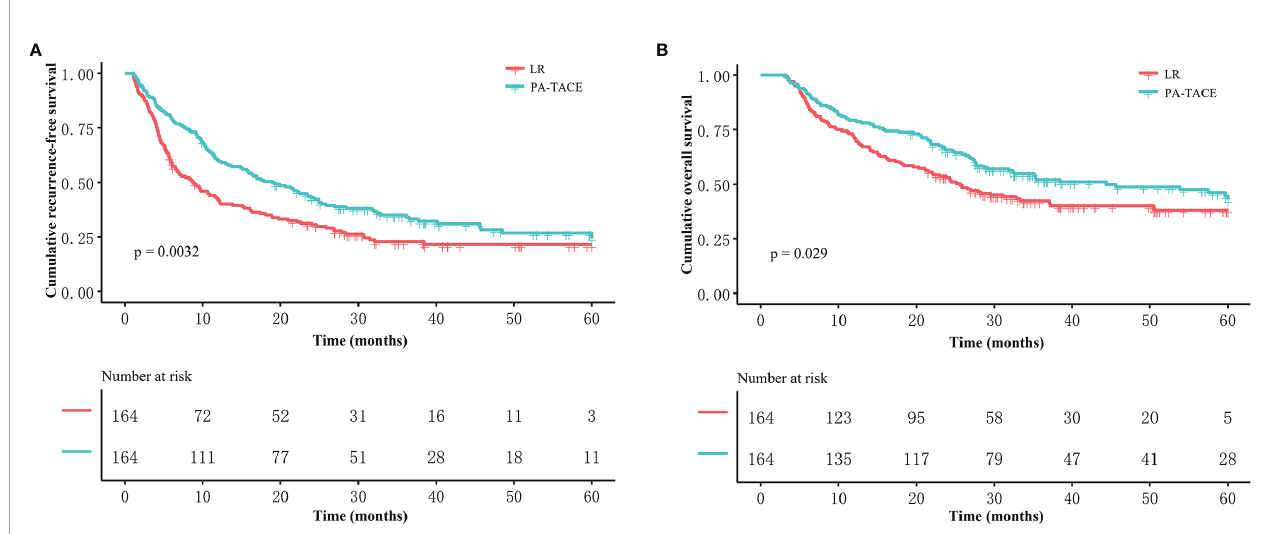
FIGURE 2 | Kaplan – Meier analysis of RFS and OS strati fi ed by treatment in the PSM cohort. Patients who received PA-TACE had better RFS (A) and OS (B) than those who underwent liver resection